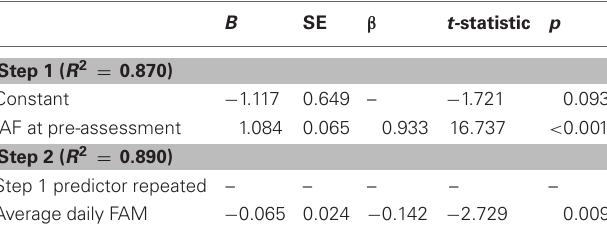
Table 2 | Predicting changes in IAF from average daily focused attention